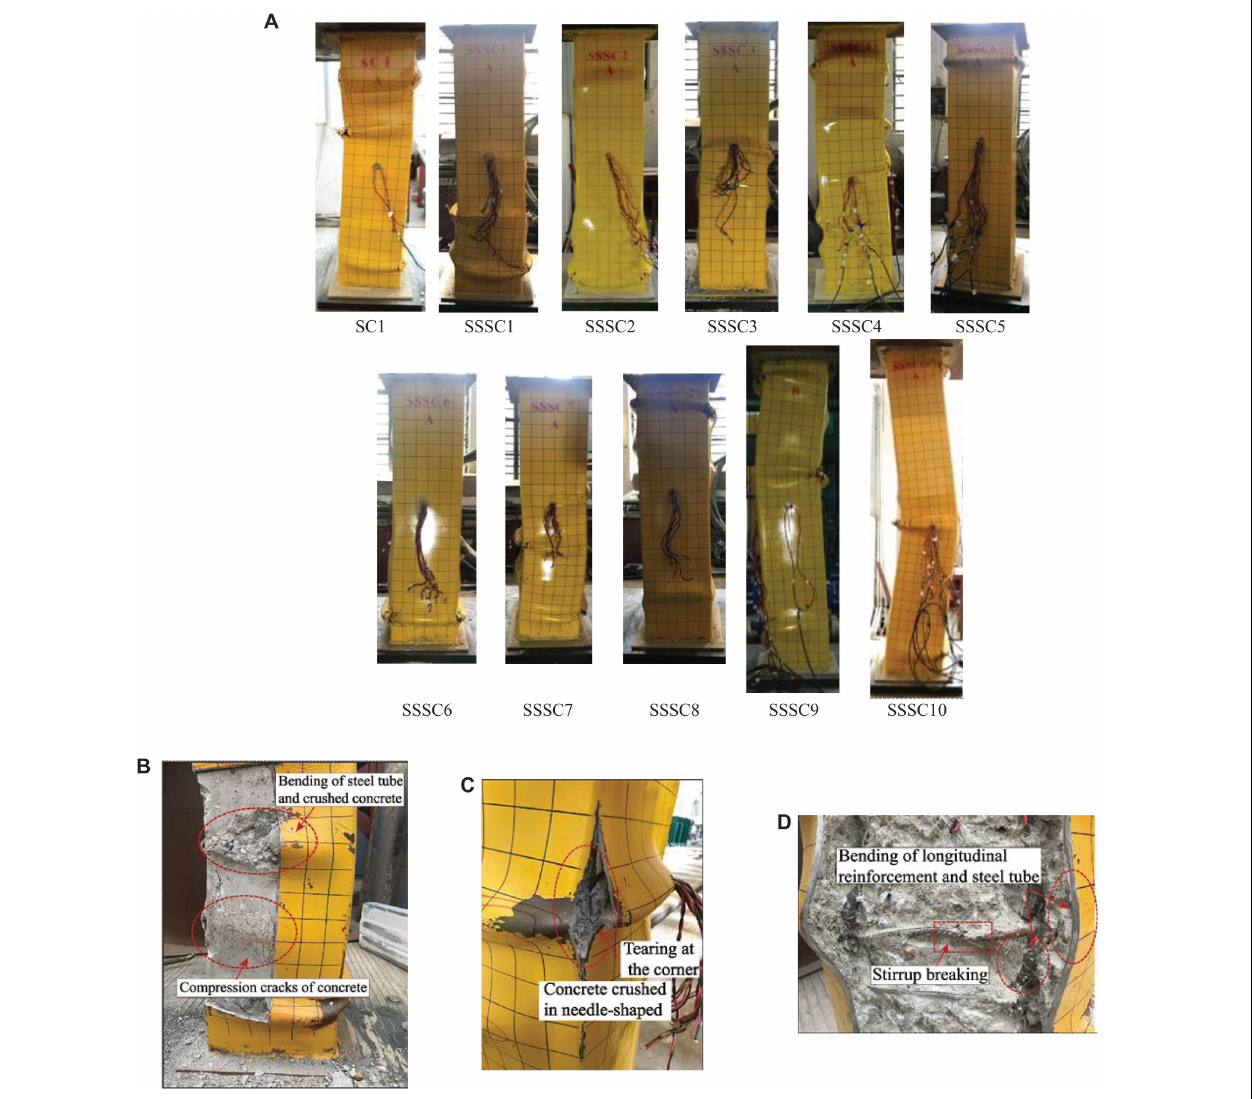
FIGURE 3 | Failure mode of specimens. (A) Final failure mode of specimens. (B) Damage of steel tube bulge area. (C) Tearing failure of steel tube. (D) Damage of stirrups and longitudinal